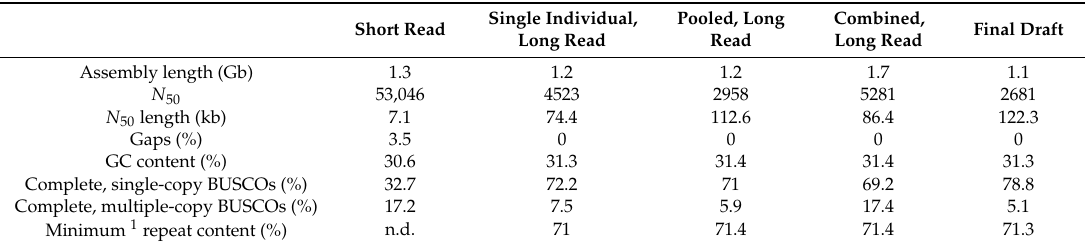
Table 2. Assembly statistics for the final draft genome and intermediate assemblies. 1. We estimated repeat content from a subset of contigs in the assembly (see Methods). n.d.: not determined.